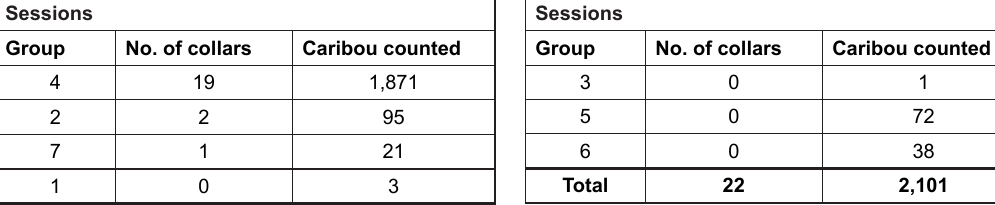
Table 42. Field data for the 2012 Tuktoyaktuk Peninsula Herd post calving